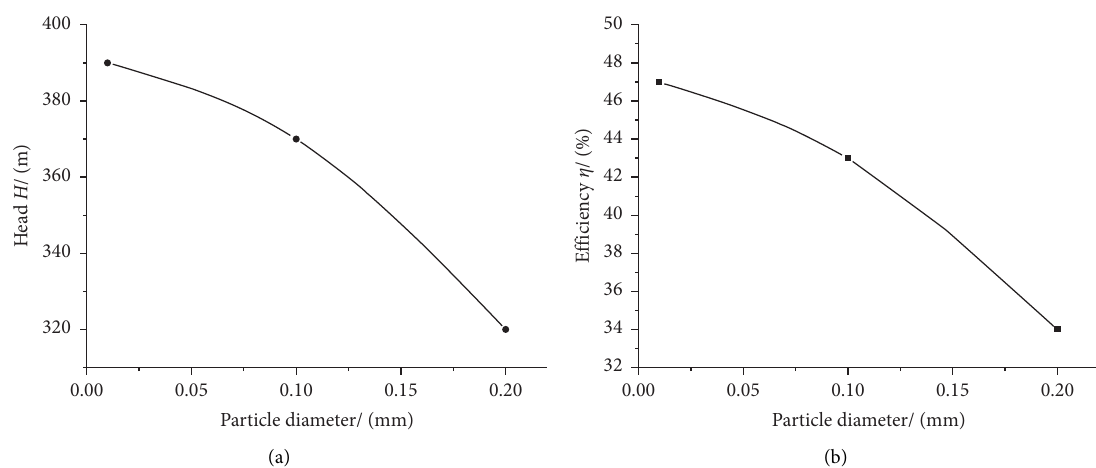
Figure 9: Characteristic curves of different particle sizes. (a) Influence of particle size on pump head. (b) Influence of particle diameter on